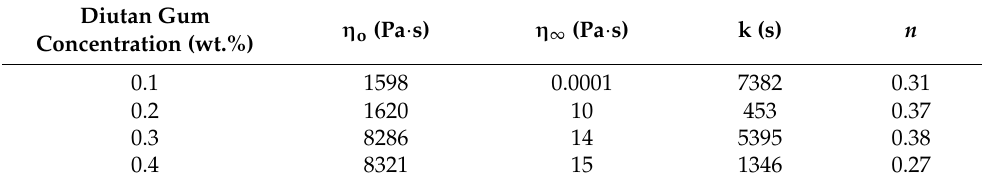
Figure 4. ( A ). Mechanical spectra for emulsions formulated with zein as a function of diutan gum concentration. ( B ). Flow curves for emulsions formulated with zein as a function of diutan gum concentration. Table 2. Fitting parameter values for the Cross model. The values were obtained by a non-linear regression